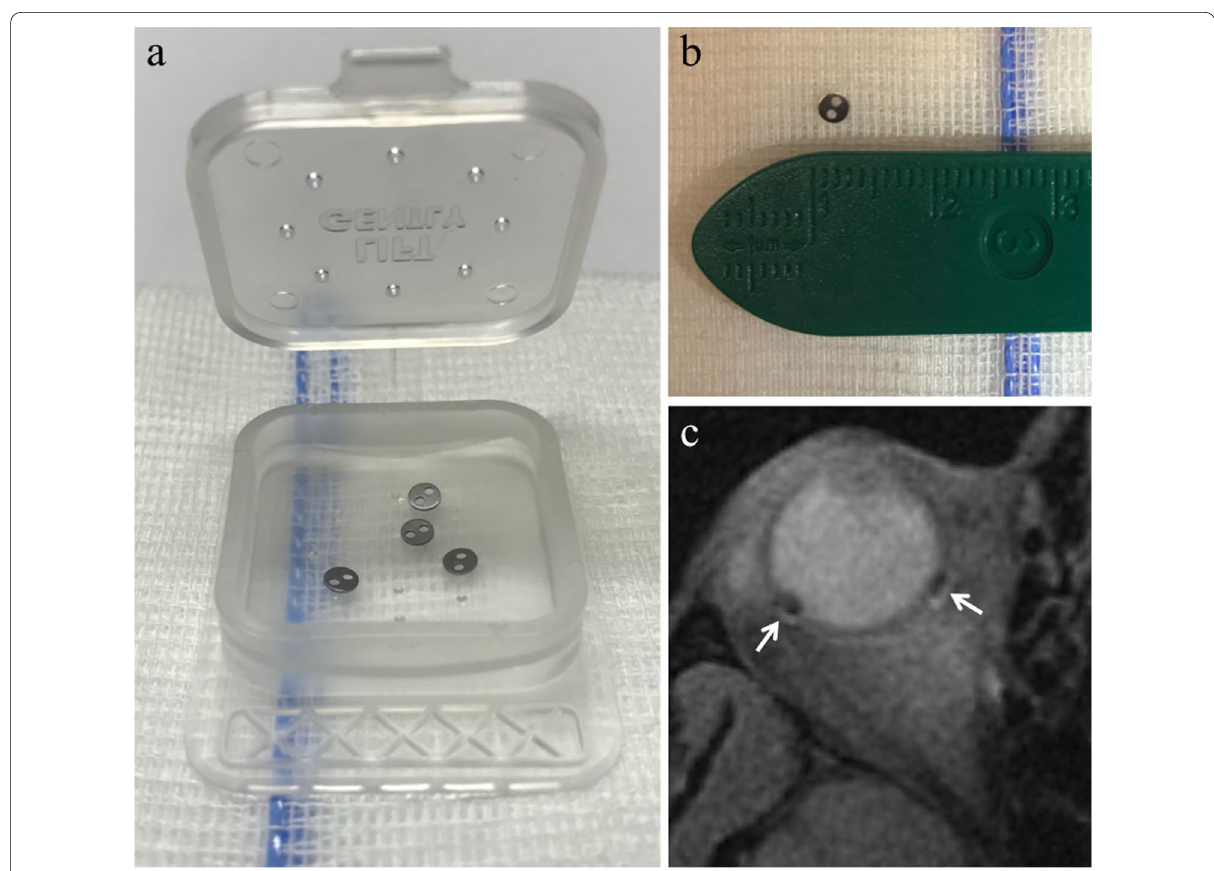
Fig. 1 Tantalum clips for proton-beam radiotherapy. a, b Tantalum clips (2.5 mm in diameter). c Fat-suppressed T1-weighted image shows the artefact produced by the clips (white arrows); the artefact is negligible since tantalum is a nonmagnetic metal